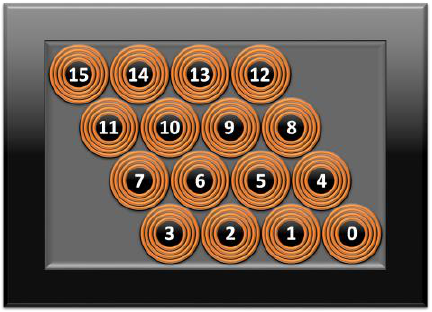
Figure 1. Proposed multi-input single output wireless power transmission (MISO-WPT) system arrangement.